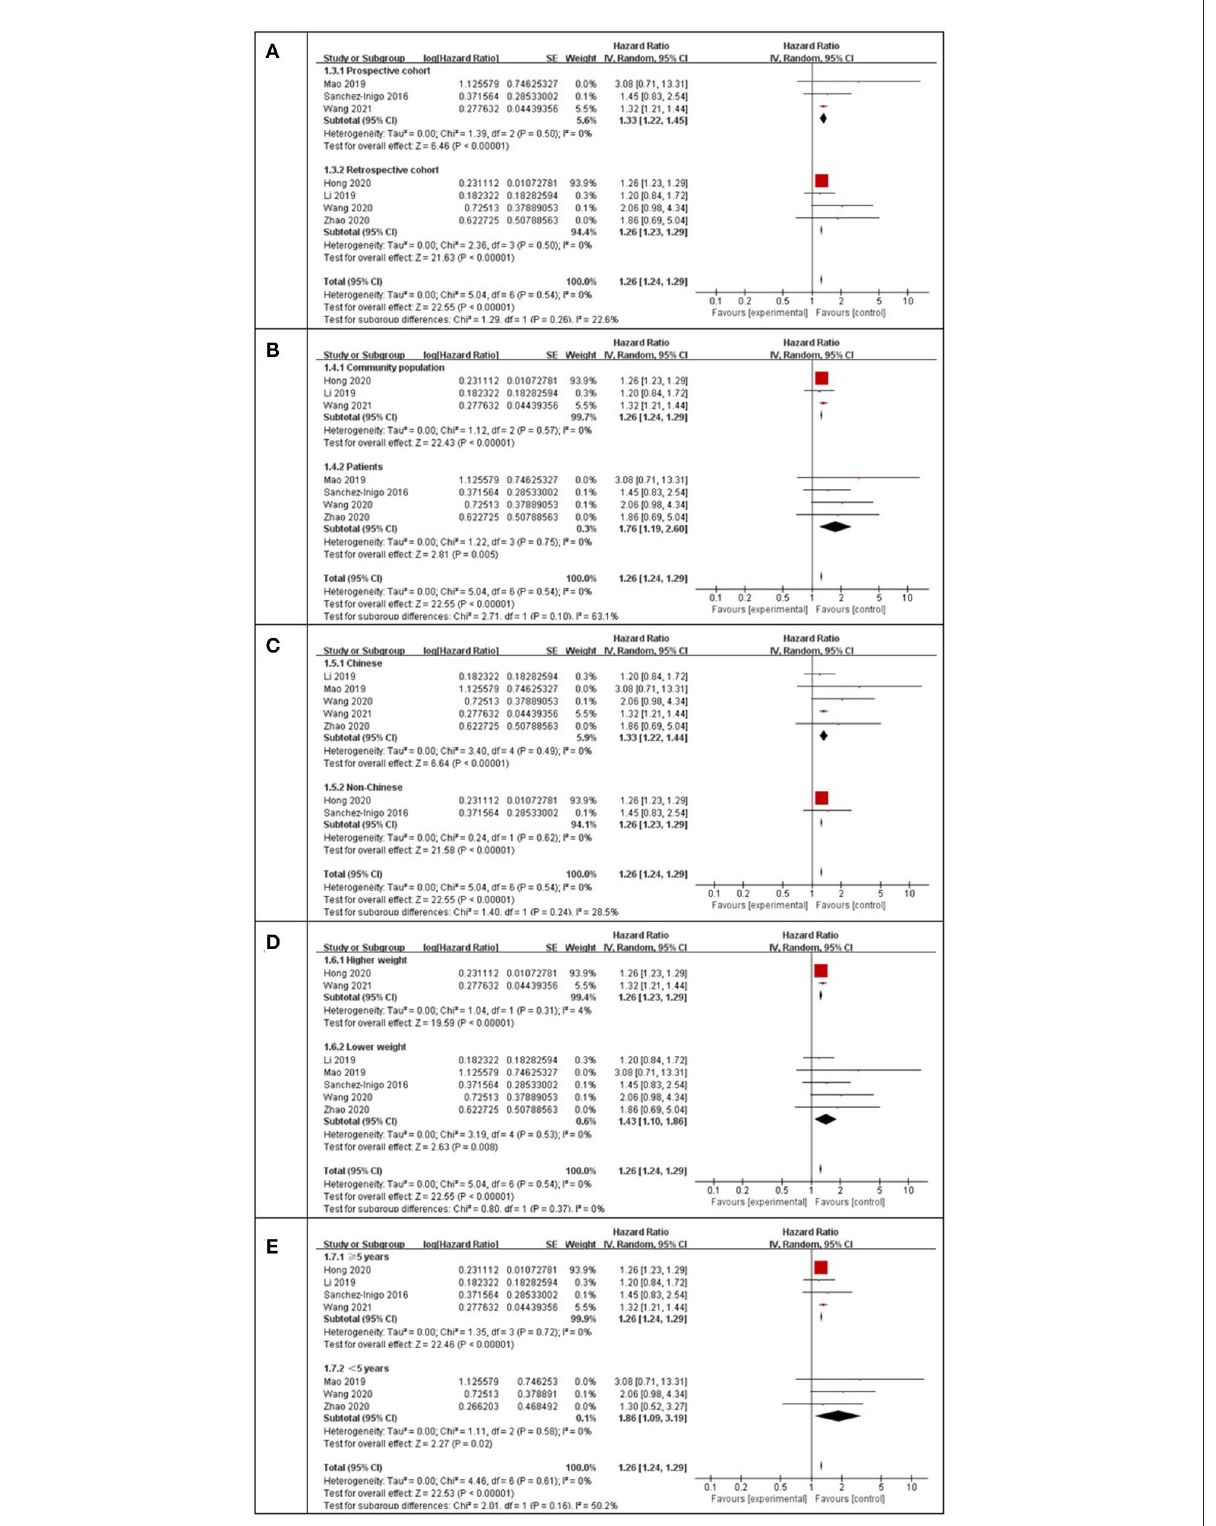
FIGURE3 Subgroup analysis for the Meta-analysis of association between the TyG index and the risk of stroke. (A) Subgroup analysis according to study design. (B) Subgroup analysis according to characteristics of participants. (C) Subgroup analysis according to the ethnicity of the population. (D) Subgroup analysis according to the weight of studies. (E) Subgroup analysis according to the length of follow-up